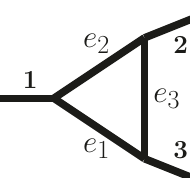
Figure 2 . Notation for external and internal edges of three-point functions. Propagator e i has mass m 2 , and external leg i has mass p 2 i